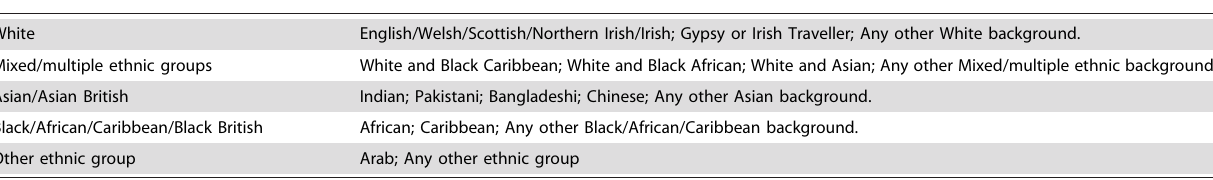
Table 1. Ethnic group classification: census classification.